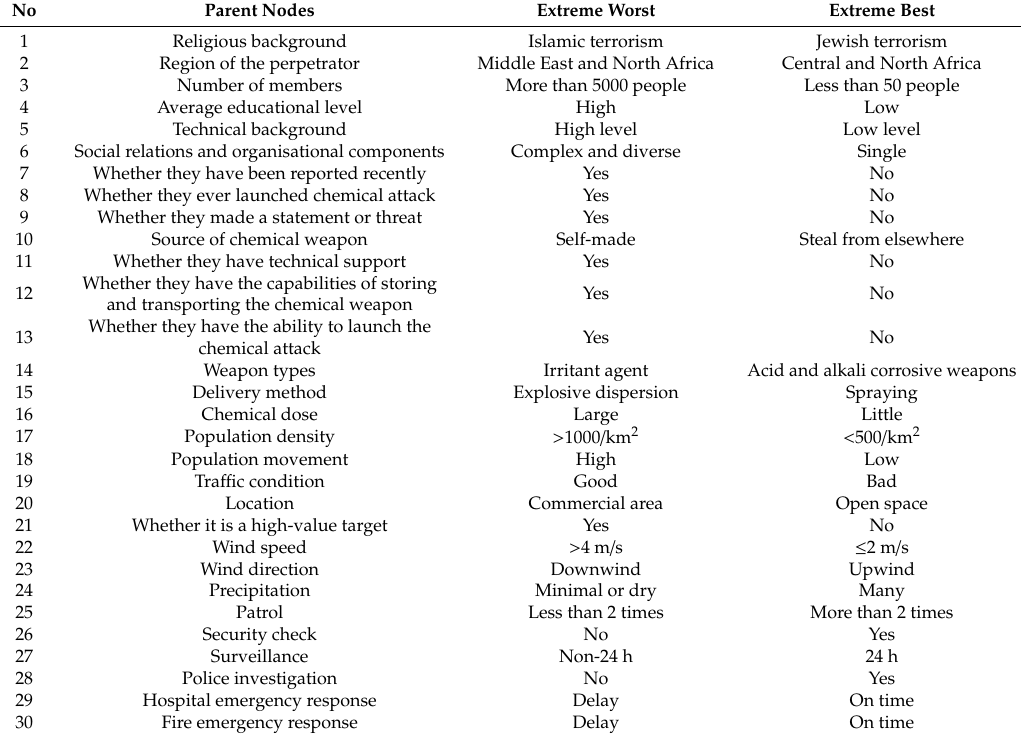
Table 3. Extreme-Condition Test of the proposed Bayesian